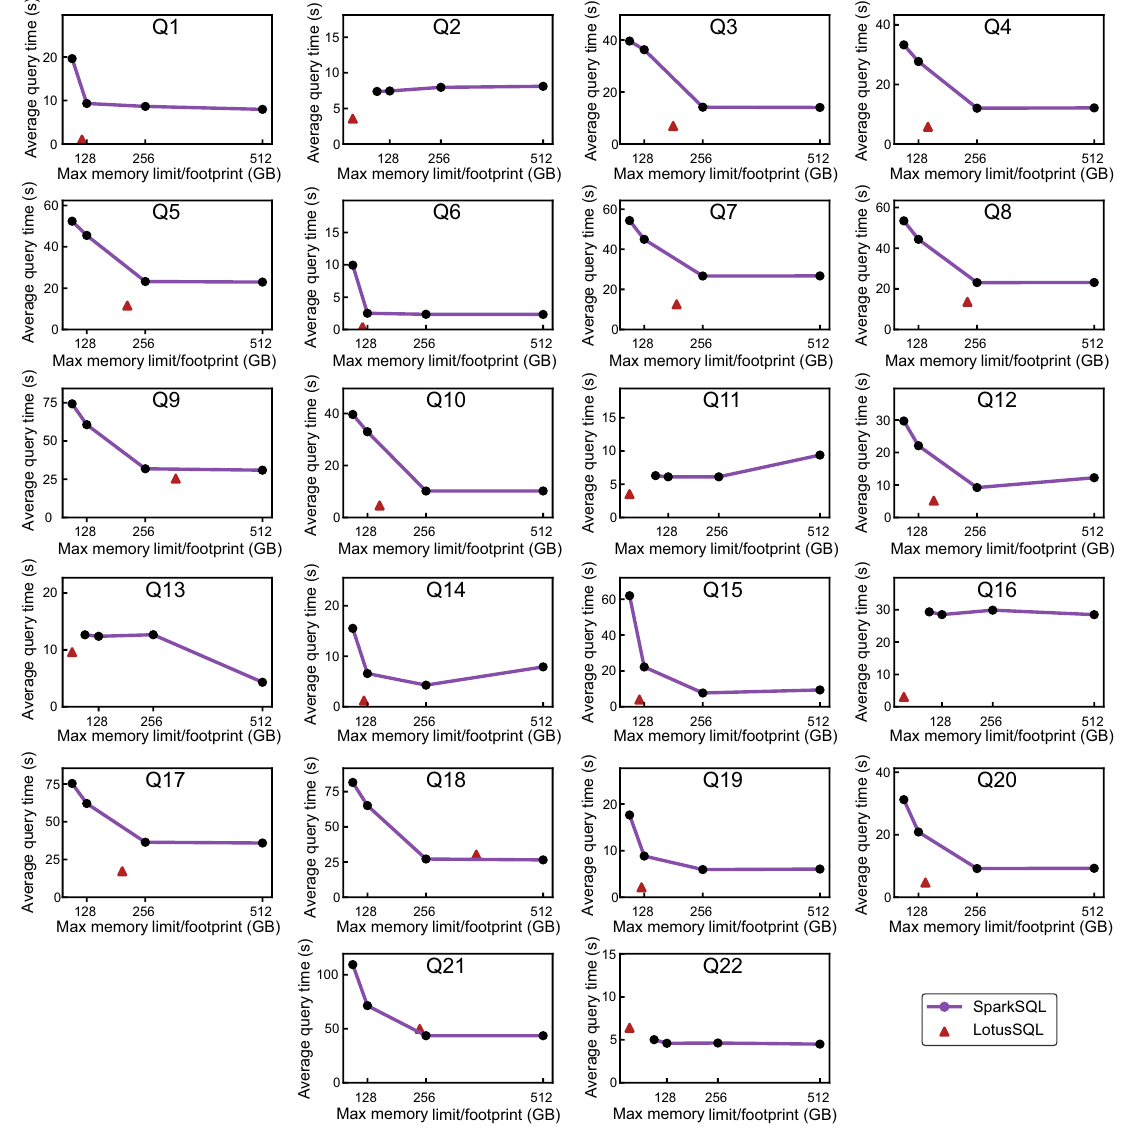
Fig. 6 TPC-H memory